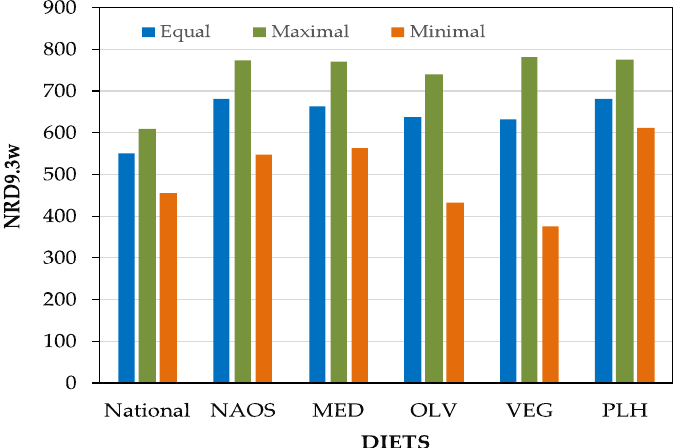
Figure 3. Nutritional index (NRD9.3 w ) of the different pre-defined diets subject to variable weighting factors of the nutrients. factors of the nutrients.